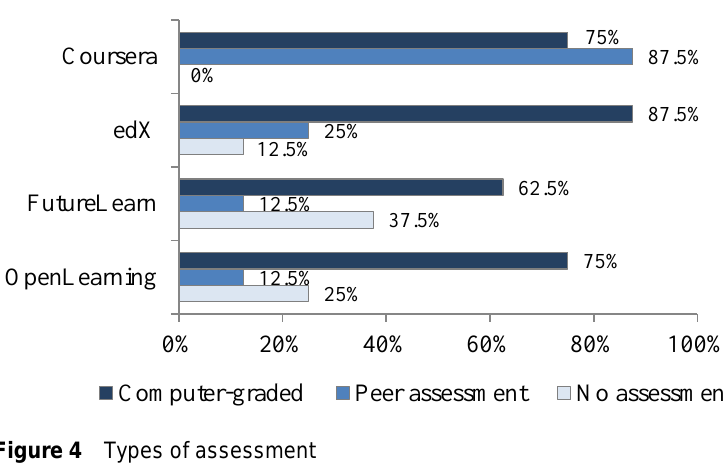
Figure 4 Types of